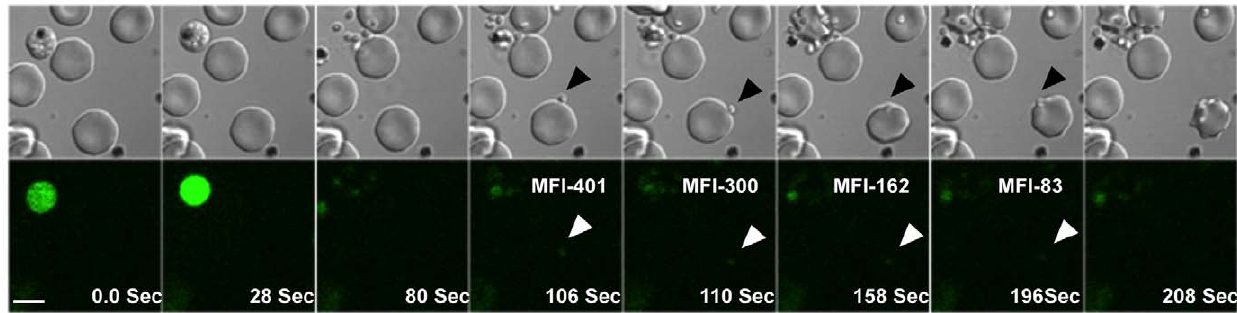
Figure 1. Cytosolic calcium levels in P.falciparum merozoites during erythrocyte invasion. Late stage P. falciparum schizonts were labeled with Fluo-4AM and added to uninfected erythrocytes to allow re-invasion. Calcium levels were monitored in released merozoites during invasion by time-lapse video microscopy. Both DIC and fluorescence images were acquired at 2 second intervals. Selected pairs of DIC and fluorescence images with time elapsed between frames in seconds (Sec) are shown. The mean fluorescence intensity (MFI) after subtraction of background in an individual merozoite that successfully completed invasion (marked by arrows) is indicated. White bar indicates 5 m m. Also see Supplementary Information, Videos S1, S2 and